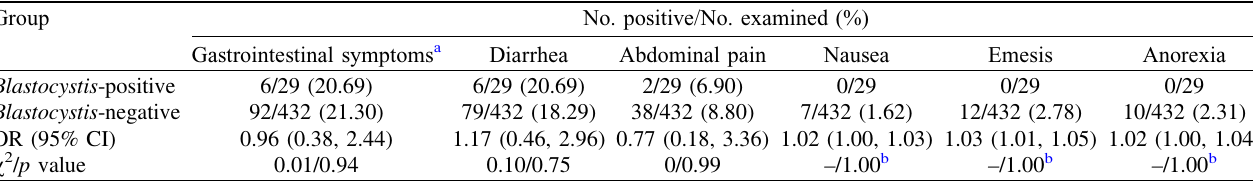
Table 2. Relationship between Blastocystis carriage and gastrointestinal symptoms. Group